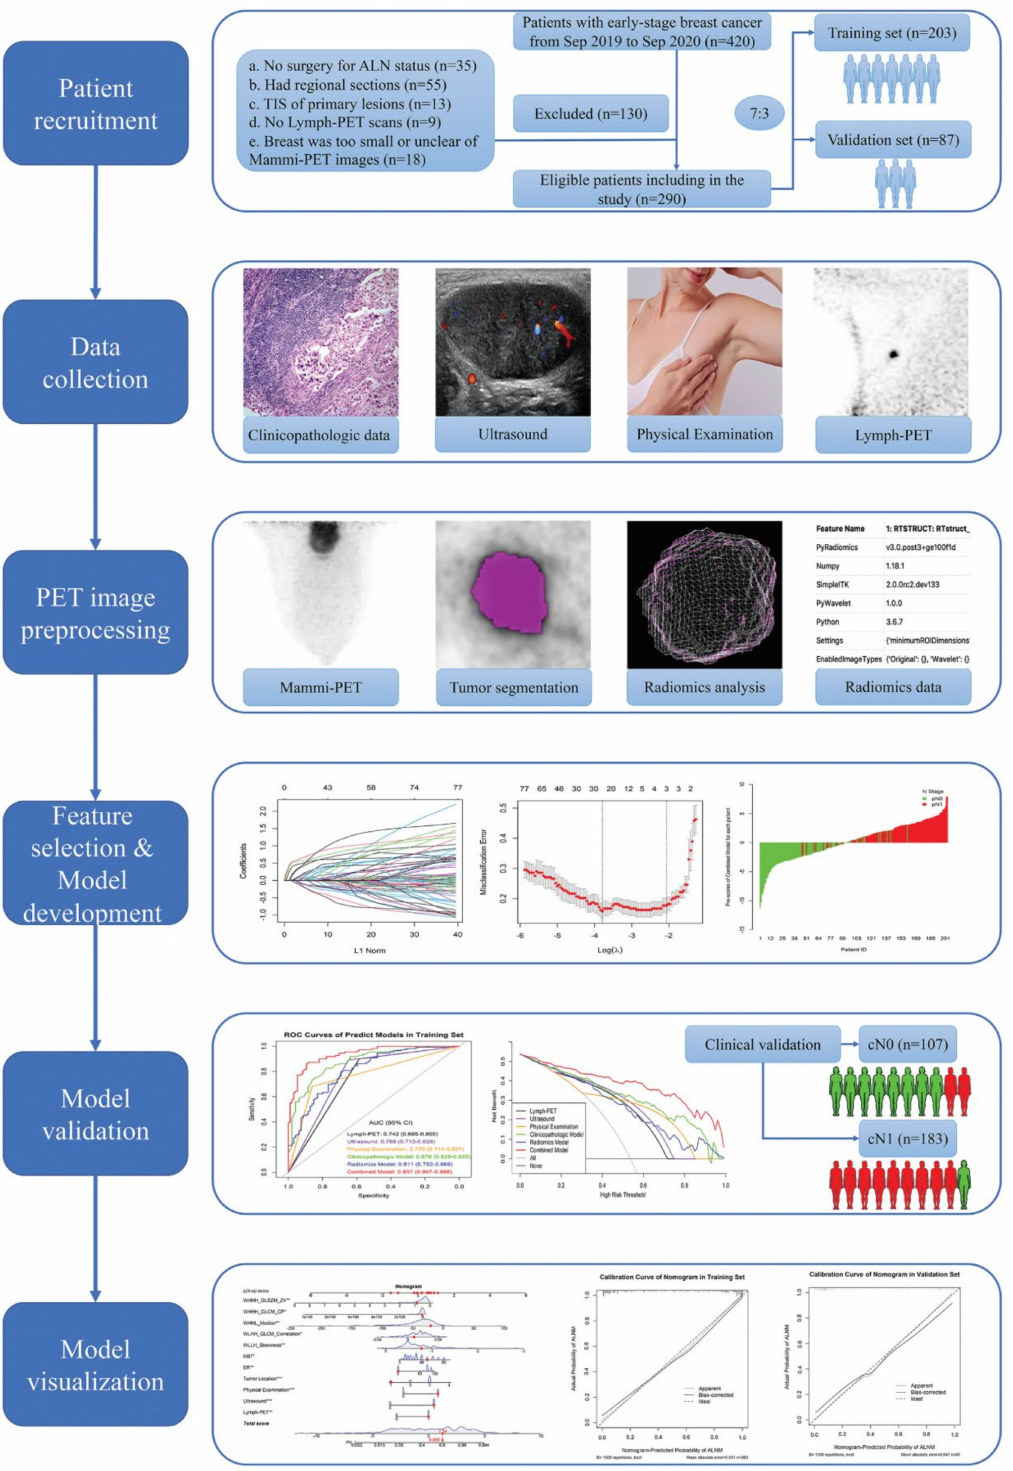
Figure 1. Patient recruitment process and study workflow. Patients were randomly divided into two sets with a ratio of 7 to 3: (1) training set, on which the best-fitting prediction models were built and tested, and (2) an internal validation set, on which performance and goodness of fit were assessed. This study conformed to the transparent reporting of a multivariable prediction model for individual prognosis or diagnosis reporting guidelines